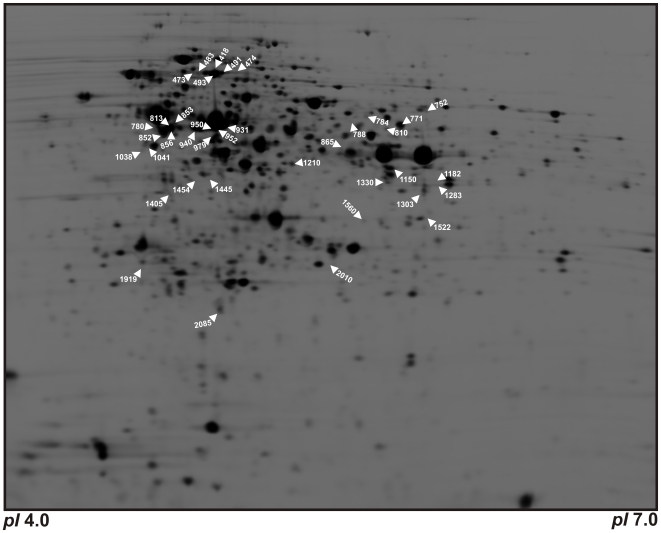
Reference soluble proteome map of L. lactis NZ9000 grown in GM17 and GCDM medium.The pI increases from 4.0 on the left to 7.0 on the right. High molecular weight proteins are in the upper part of the figure, low molecular weight proteins in the lower region. Differentially expressed proteins are annotated by spot numbers; their protein description is given in Table S1.